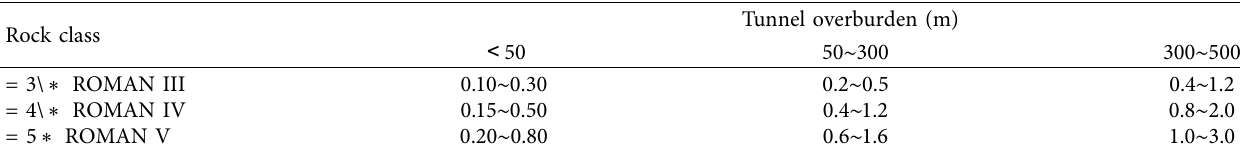
Figure 1: Tunnel size and excavation limit: (a) horseshoe section; (b) rectangular with arch crown section. Table 1: Allowable relative convergence index for